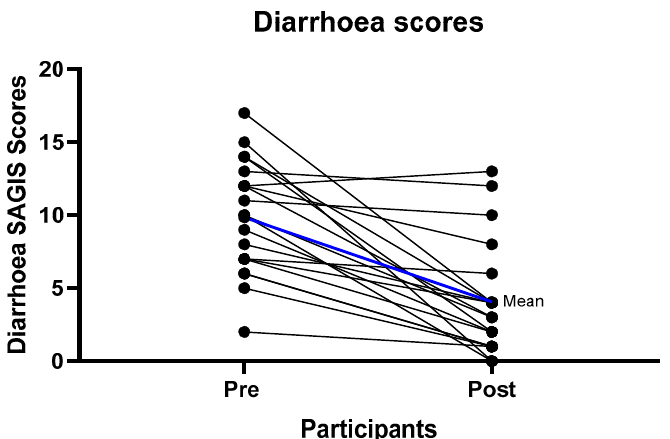
Figure 2. Individual gastrointestinal symptom improvement (Total Structured Assessment of Gastrointestinal Symptoms (SAGIS) scores) from baseline to follow-up. Mean difference from the pre intervention to follow-up scores was 11.35 with a standard deviation of 10.75 p < 0.001.